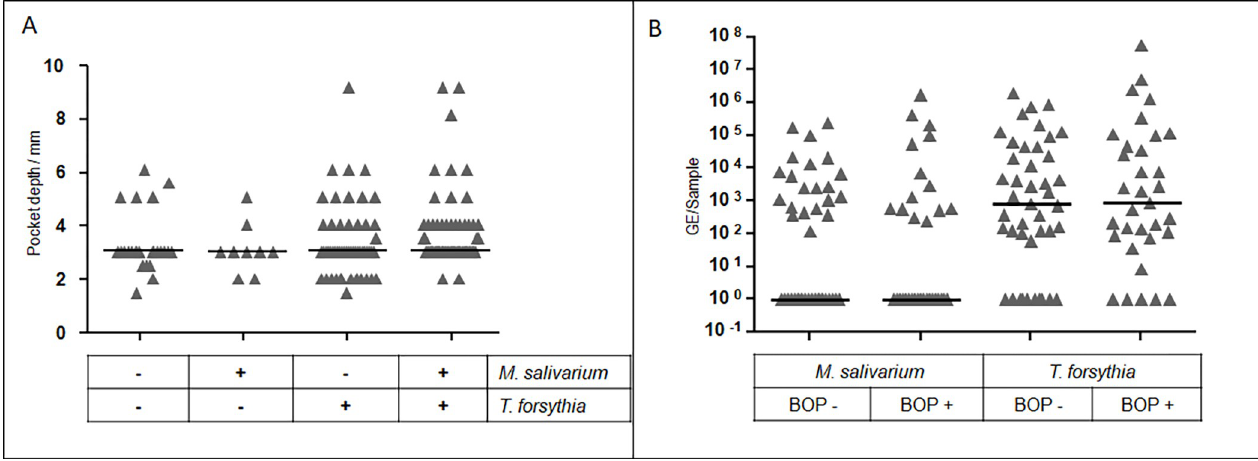
Fig 3. Association between T . forsythia and M . salivarium and clinical signs of gingival inflammations. Scatter plot of the (A) pocket depth (mm) and (B) bleeding on probing positive (BOP+) or negative (BOP-) samples divided in groups of presence (+) and/or absence (-) of M . salivarium and T . forsythia . The bars represent